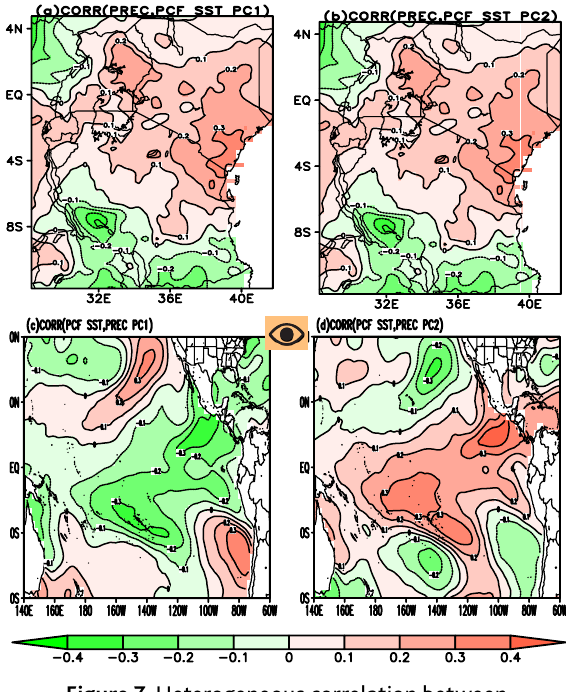
Figure 7. Heterogeneous correlation between precipitation over the study area and PC 1 and 2 of Pacific SST (a and b) and heterogeneous correlation between Pacific Ocean and PC 1 and 2 of precipitation (c and